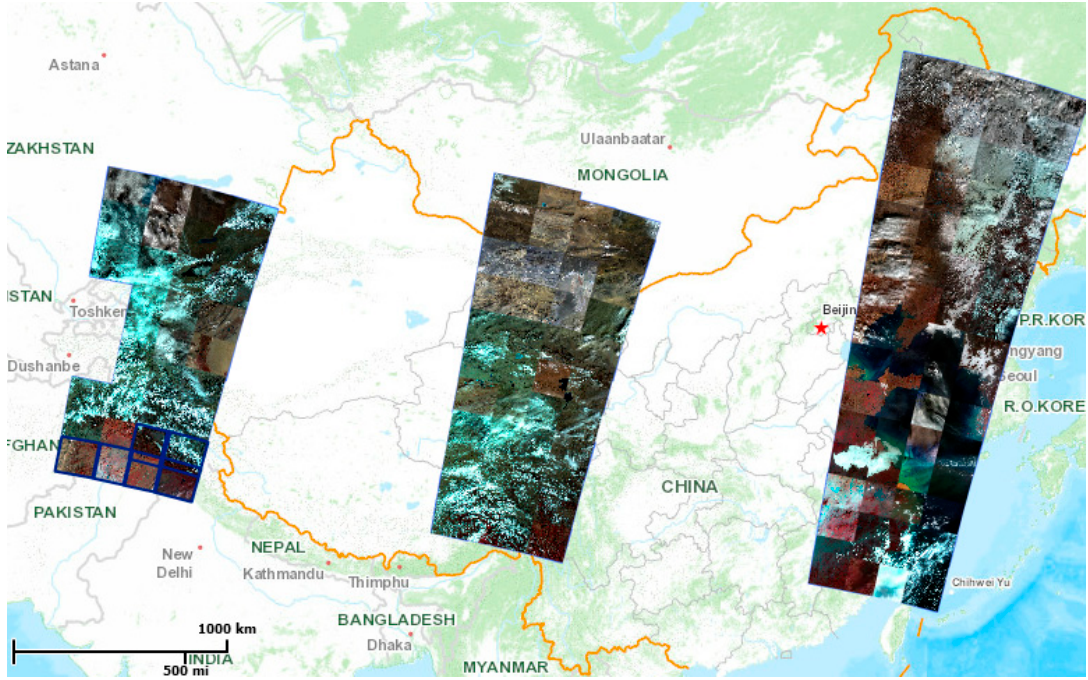
Figure 1. Footprint of Gaofen-1 WFVs in China in a single day (2013-12-4). With the combination of four cameras on-board Gaofen-1 satellite, the swath of WFV could reach to ~800 km.